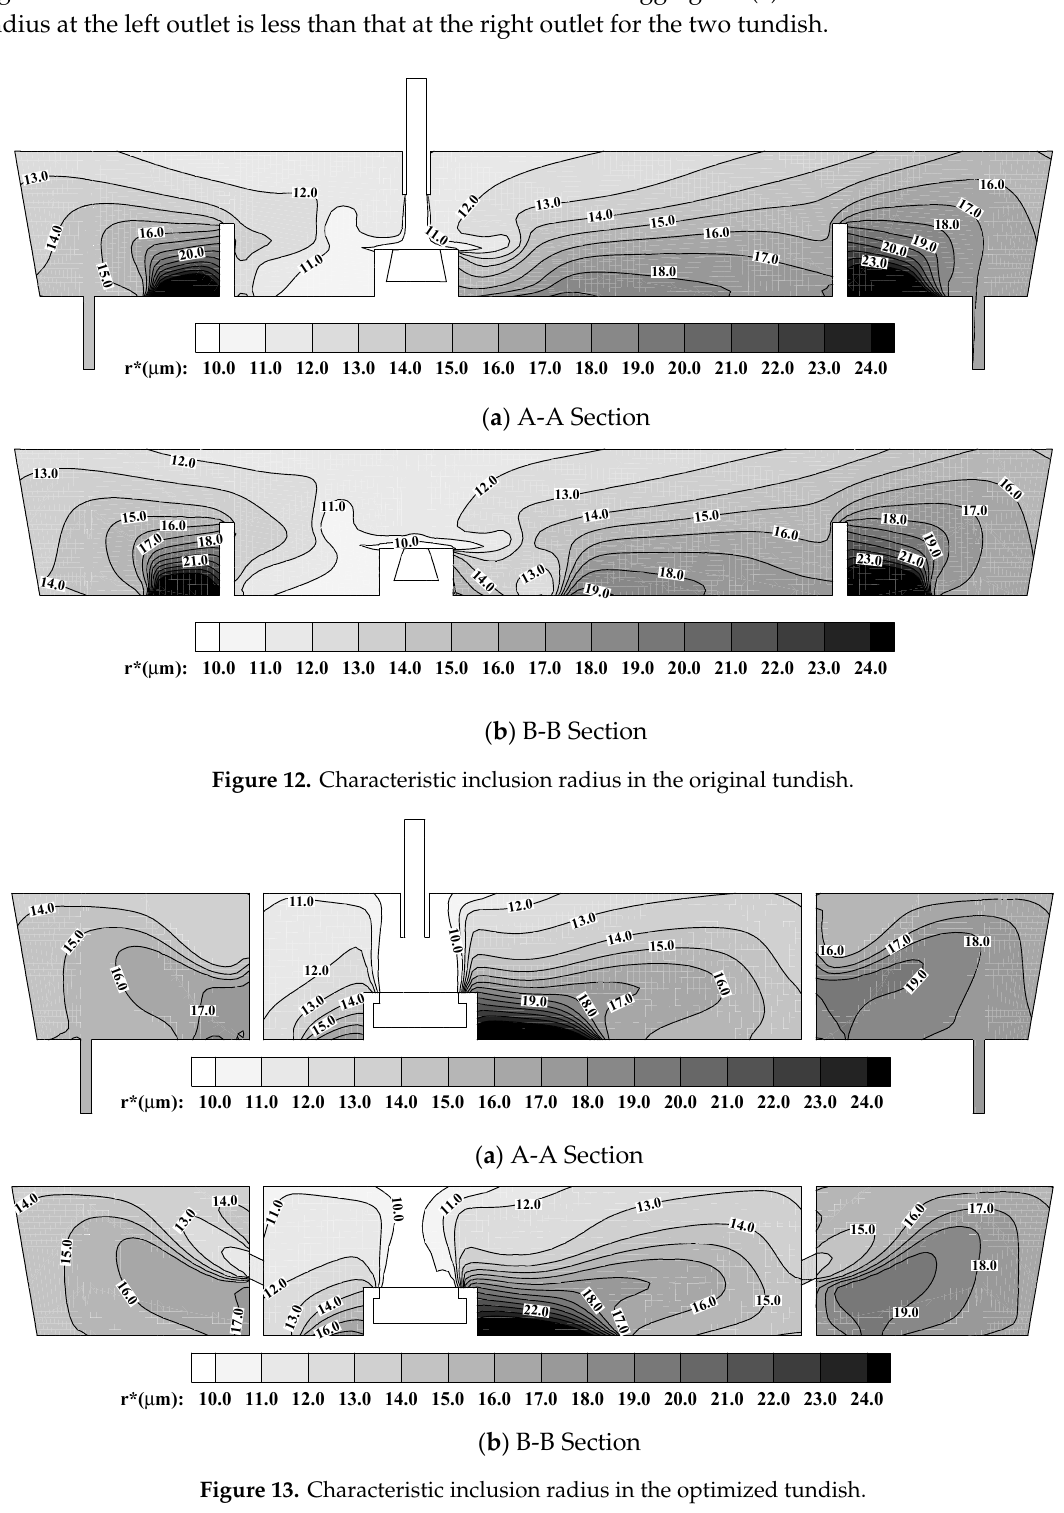
Figure 11. Inclusion volume concentration distribution in the optimized tundish.